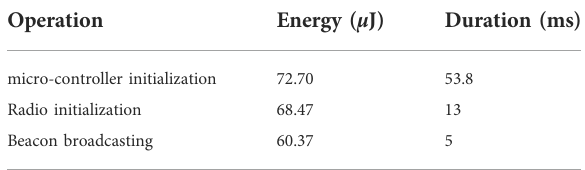
TABLE 4 Energy statistics of one BLE beacon packet broadcasting (Li et al.,